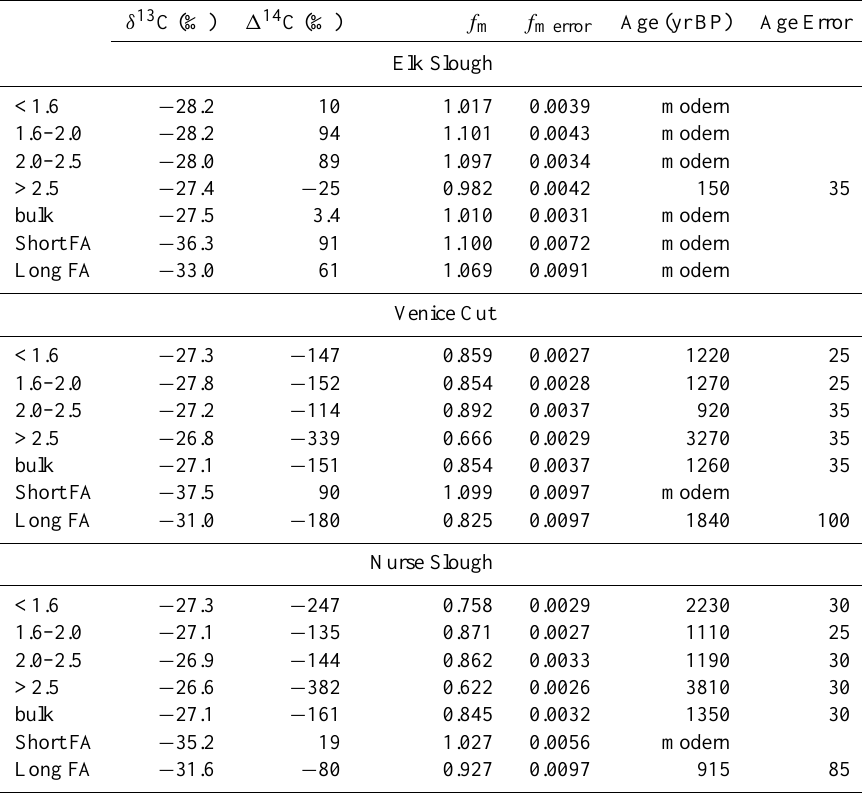
Table 1. Stable and radiocarbon isotope data for OC in density fractions, bulk OC and fatty acids for Elk Slough, Venice Cut and Nurse Slough